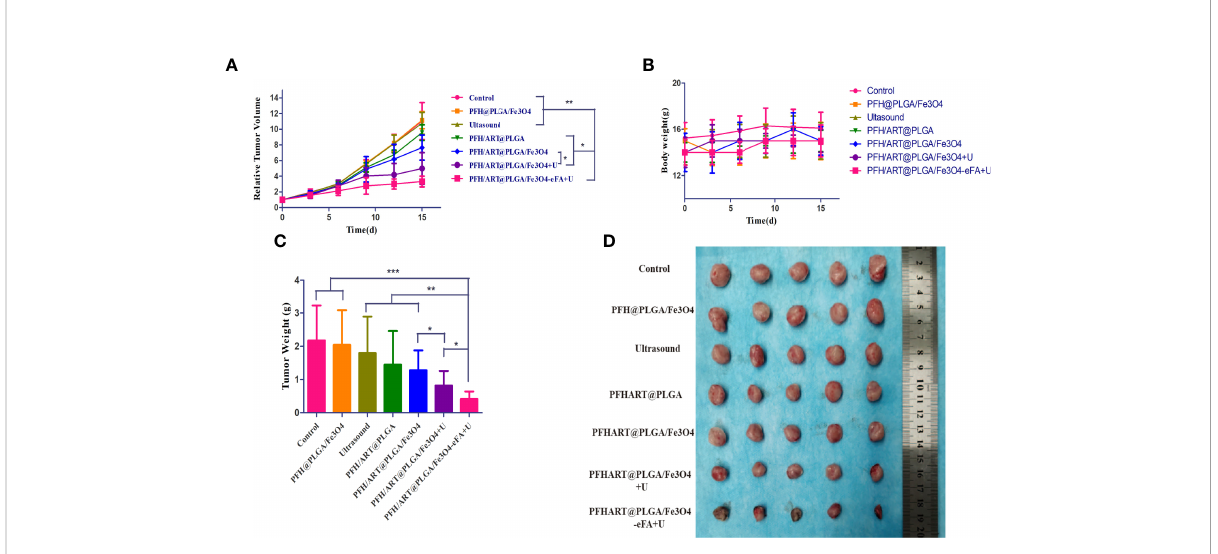
FIGURE 8 In vivo treatment. (A) The growth curve of murine in situ breast cancer tumors under different treatment conditions. (B) The body weight curves of the mice under different treatment conditions. (C) Quantitative analysis of the weights of the tumorsin mice under different treatment conditions. (D) Tumors harvested from each group at 15 d post treatment. The levels of signi fi cance wereset to values of *p < 0.05, **p < 0.01, and ***p < 0.001. The data are shown as the mean ± s.d. n =